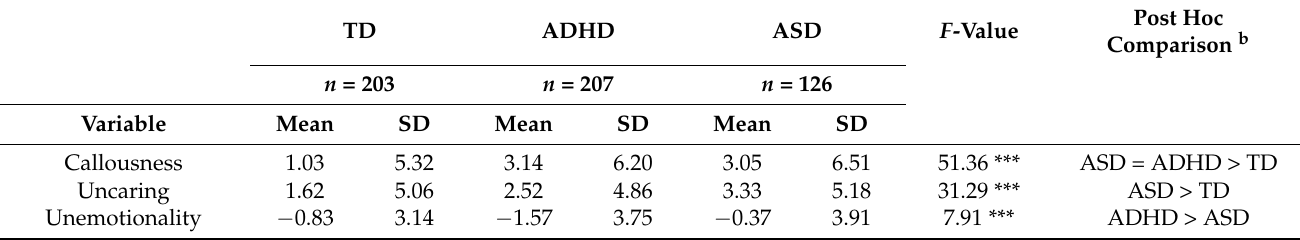
Table 4. Comparisons of Difference Scores Between Parent-Reported and Adolescent-Reported Callous–Unemotional Traits Among TD, ADHD, and ASD Groups a .